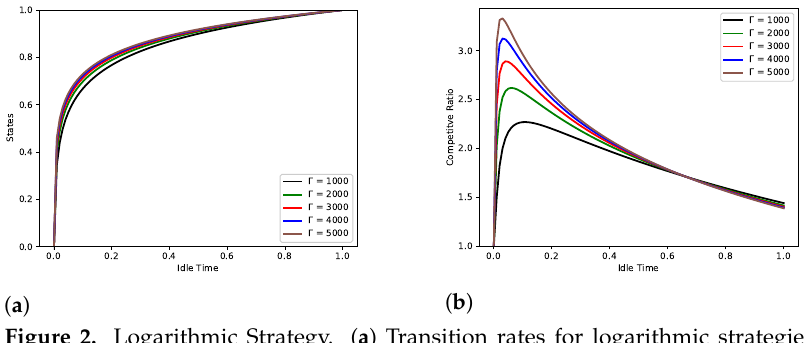
Figure 2. Logarithmic Strategy. ( a ) Transition rates for logarithmic strategies, general system; ( b ) competitive ratios for logarithmic strategies, general system.